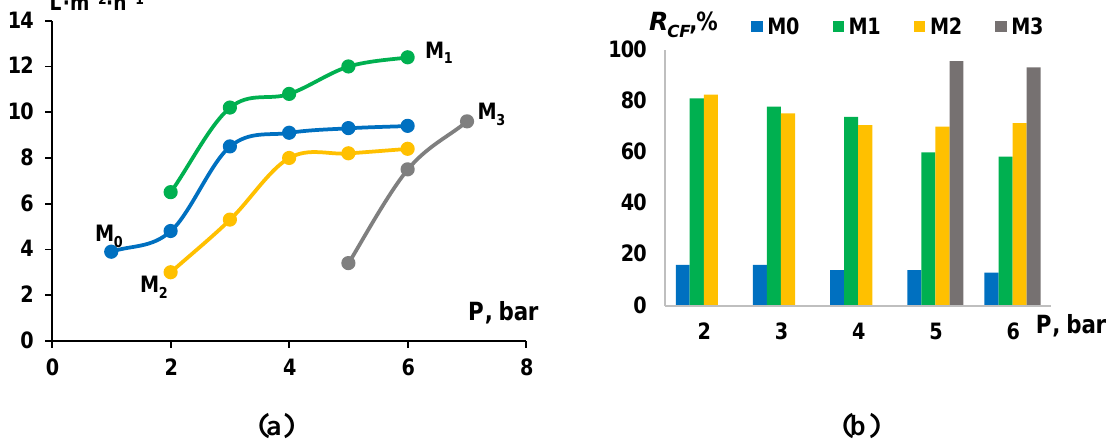
Figure 7. Dependence of 2 wt.% cutting fluid emulsion flux ( a ) and cutting fluid rejection ( b ) on transmembrane pressure during ultrafiltration.